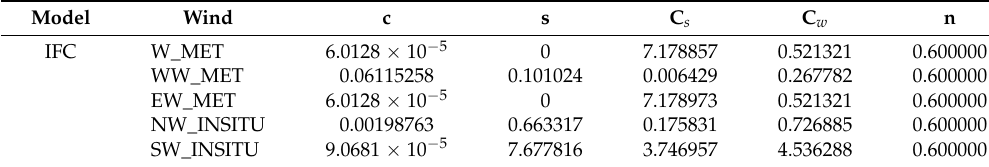
Table A2. Coefficients of IFC Equation (A2) by wind